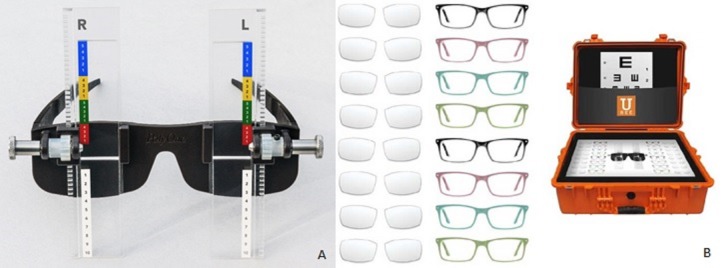
USee device and kit.(A) USee device with dials that move lens bar to appropriate refractive power, (B) USee EyeOpener kit including USee device, plastic frames, pop-in lenses, and visual acuity chart.